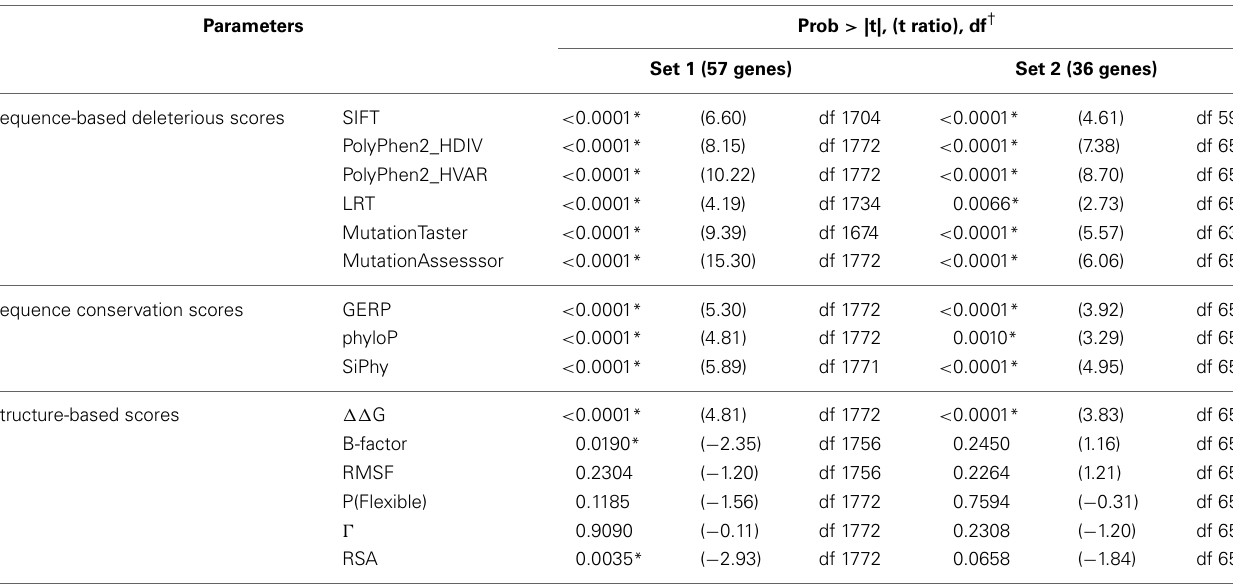
Table 3 | T -test statistics for gene sets 1 and